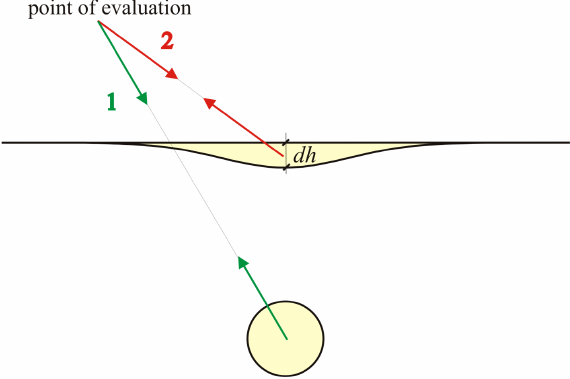
Figure 1. The deformation of the equipotential surfaces occurs due to (1) the tunnelling and (2) vertical deformations. The ar- rows visualize those gravitational effects, which are can- celled due to the mass removal.